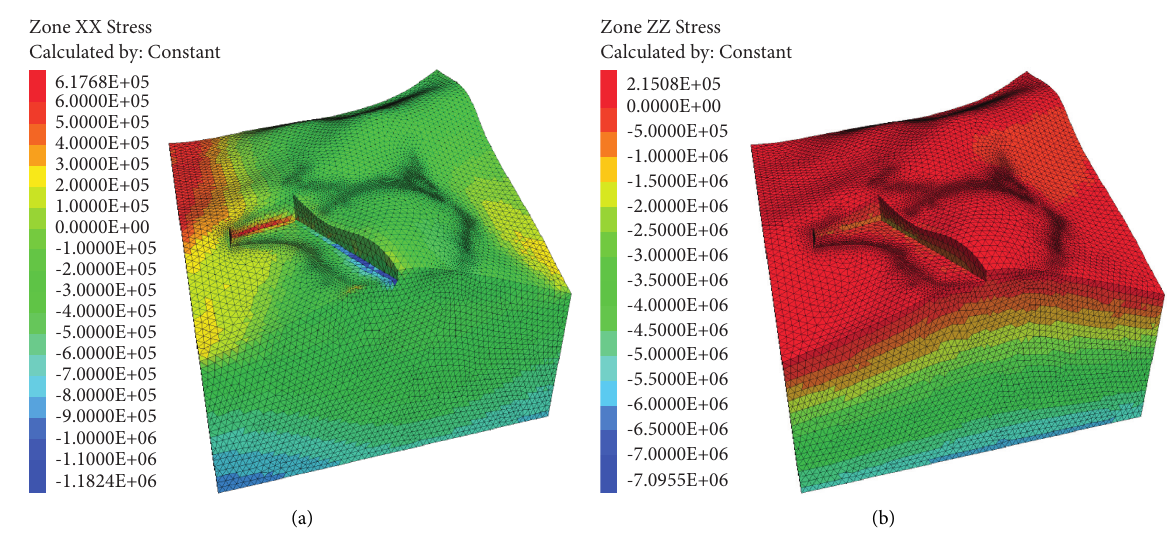
Figure 7: Stress nephogram after first excavation. (a) X -direction stress nephogram and (b) Z -direction stress